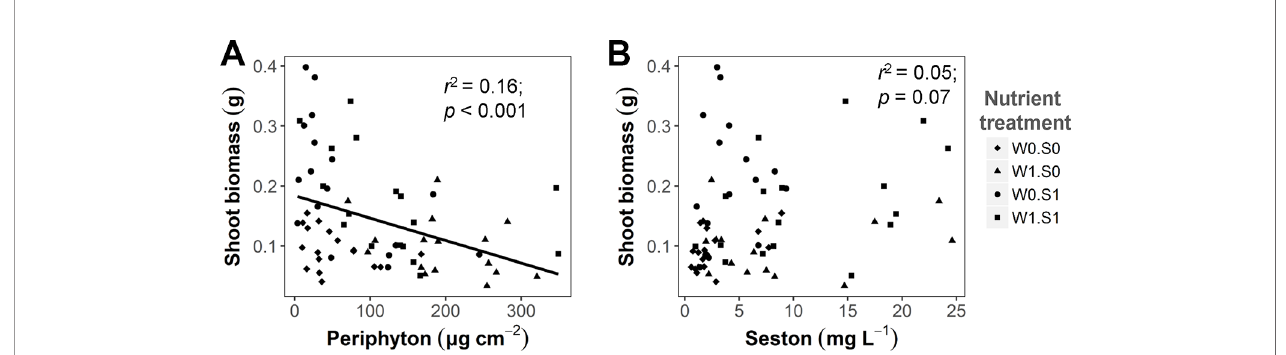
FIGURE 3 | The relationship between algae growth and plant shoot biomass at the end of the experiment. (A) Periphyton biomass density (dry weight) and plant shoot biomass (dry weight per vase); (B) Seston concentration (dry weight) and plant shoot biomass. Linear regression test results are shown in the fi gures. See caption of Figure 2 for an explanation of the abbreviations of the nutrient